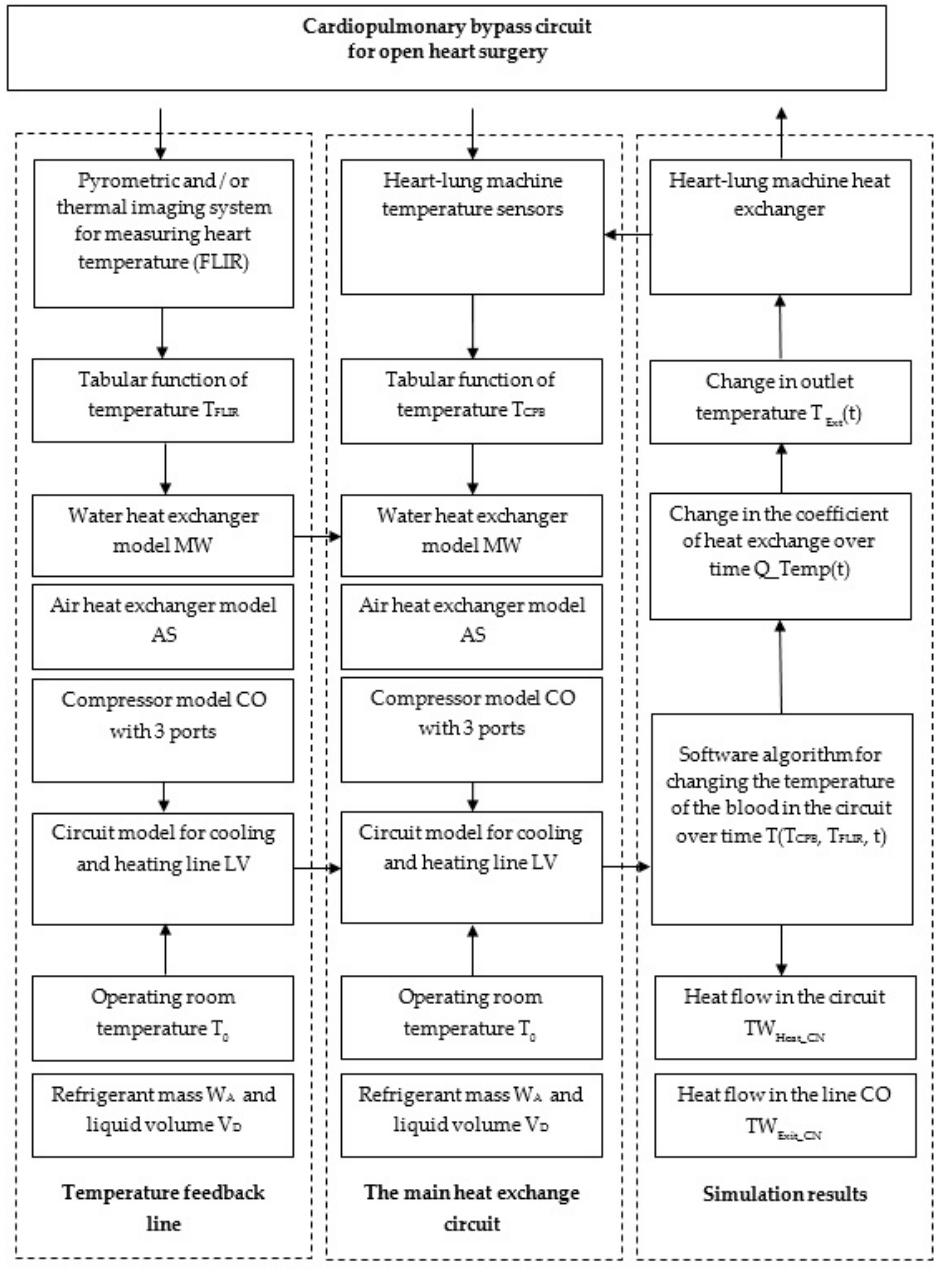
Figure 5. Block diagram of the temperature control system in the heart-lung machine’s heat ex- changer.